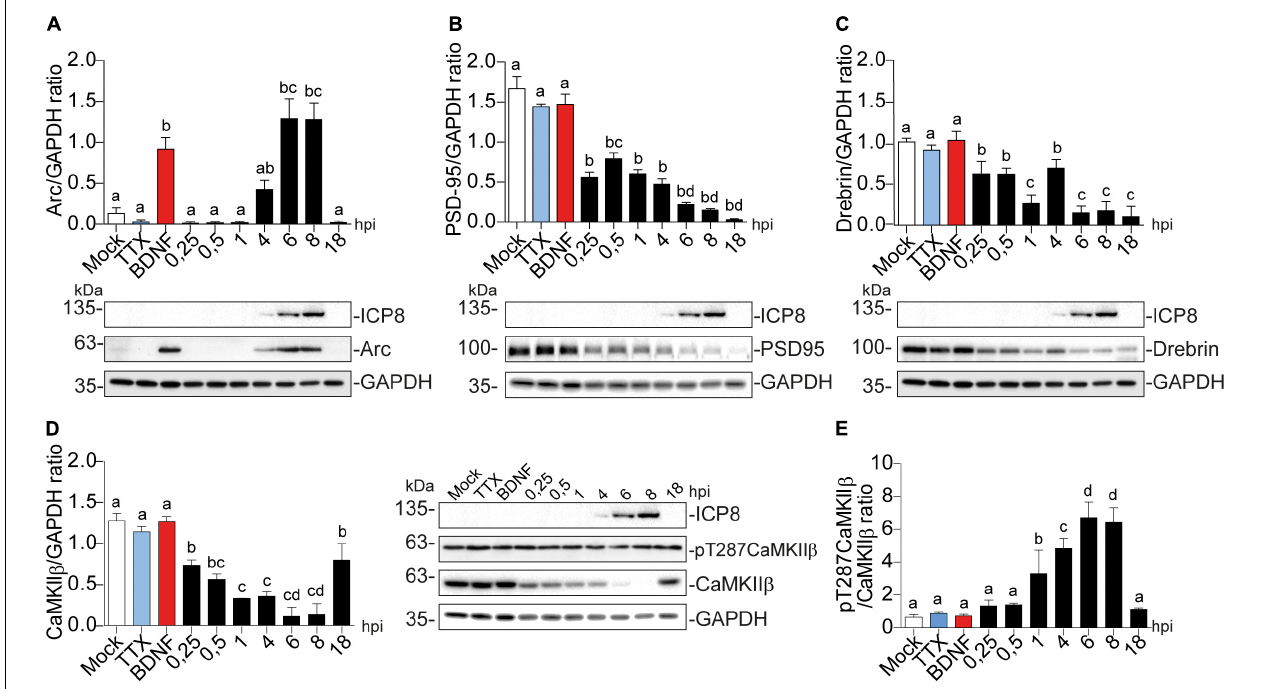
FIGURE 2 | Arc protein expression is increased in cortical neurons infected with HSV-1, while CaMKIIb, Drebrin, and PSD-95 expression are decreased. Quantification of immunoblot analyses showing (A) Arc and its dendritic binding partners: (B) PSD-95, (C) Drebrin, (D) CaMKII β (left panel) and pT287 CaMKII β (right panel) during infection kinetics with HSV-1 (Mock, 0.25; 0.5; 1, 4, 6, 8, and 18 hpi). BDNF and TTX are used as positive and negative controls of Arc induction, respectively. After gel scanning and densitometry quantitation, the results were expressed as the ratio of protein levels normalized to total GAPDH. Statistical significance was determined by One-Way ANOVA, followed by Tukey’s test. Bars represent the mean ± SD of biological replicates. Different letters above the mean bars apply to significant differences between groups p < 0.05. The blots are representative of three independent